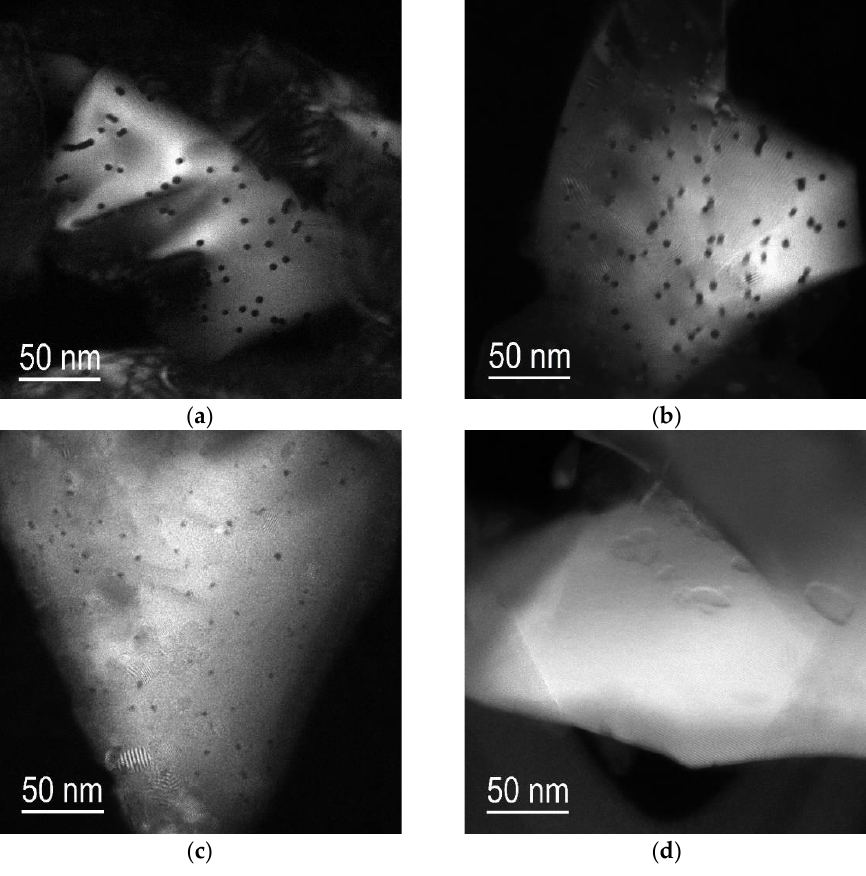
Figure 3. DF TEM images of n-Si 3 N 4 irradiated with Bi ions at electronic stopping powers of ( a ) 36 keV/nm; ( b ) 29.4 keV/nm; ( c ) 20.5 keV/nm; and ( d ) 11.6 keV/nm.